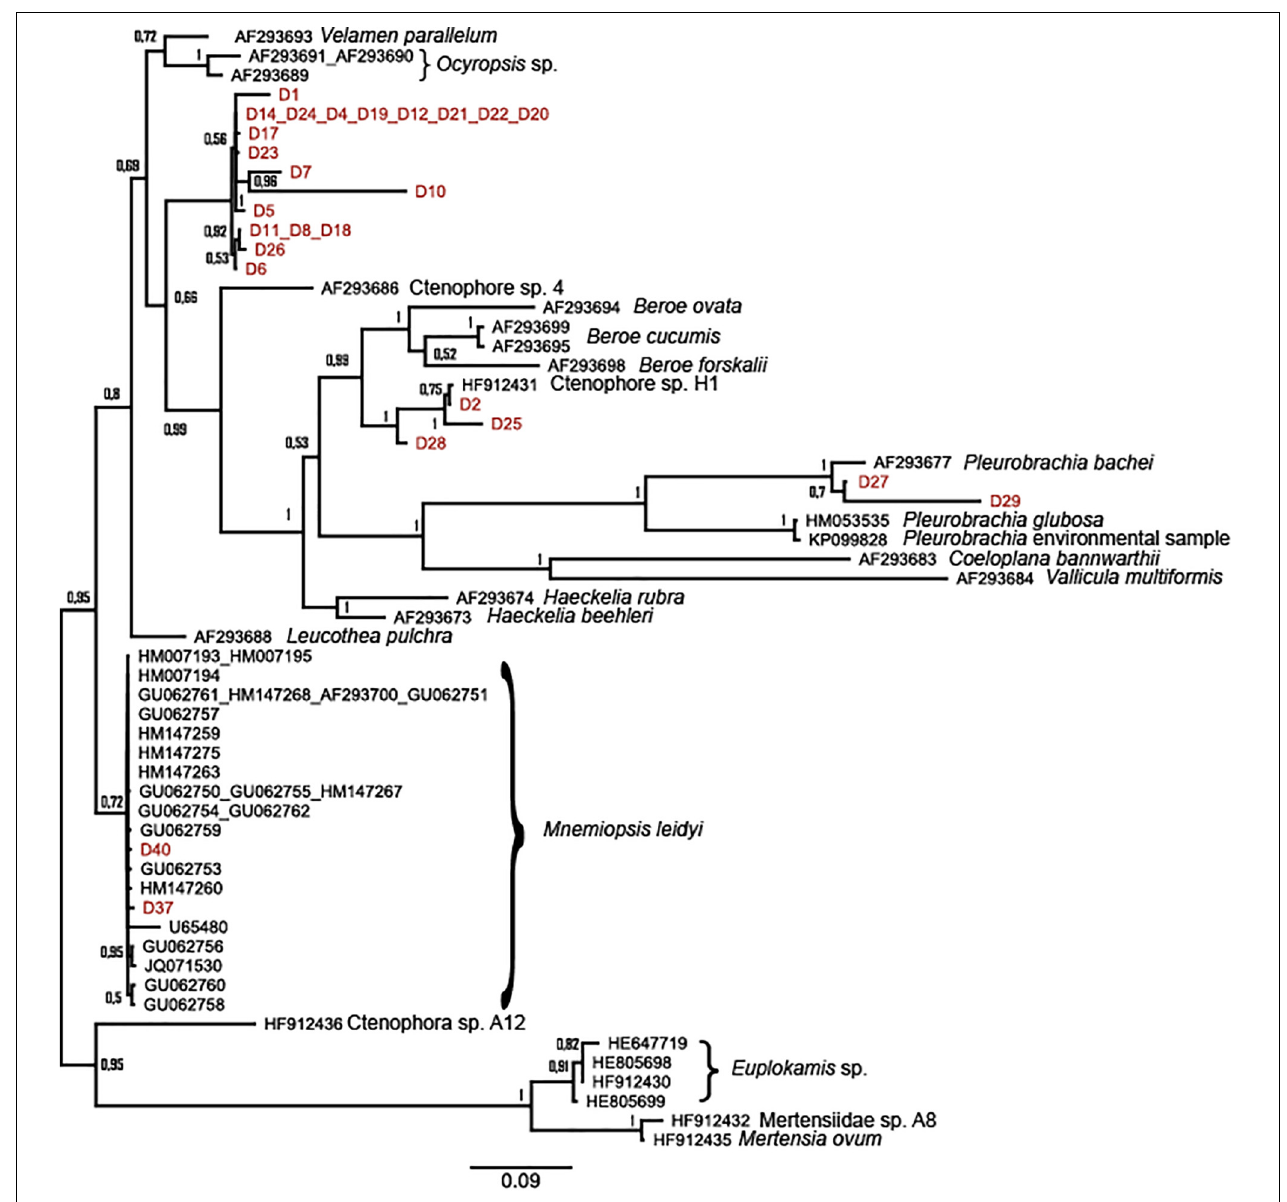
FIGURE 3 | Maximum-likelihood tree for ITS1 of all ctenophore sequences in GenBank together with specimens collected in this study by the citizen science approach (marked red, D1-D40, see Table 1 for more